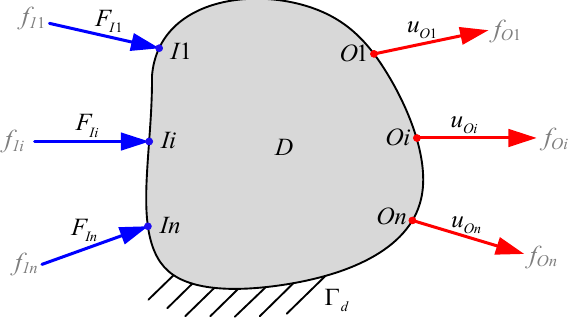
Figure 2. Design domain and boundary conditions of a MIMO compliant mechanism.